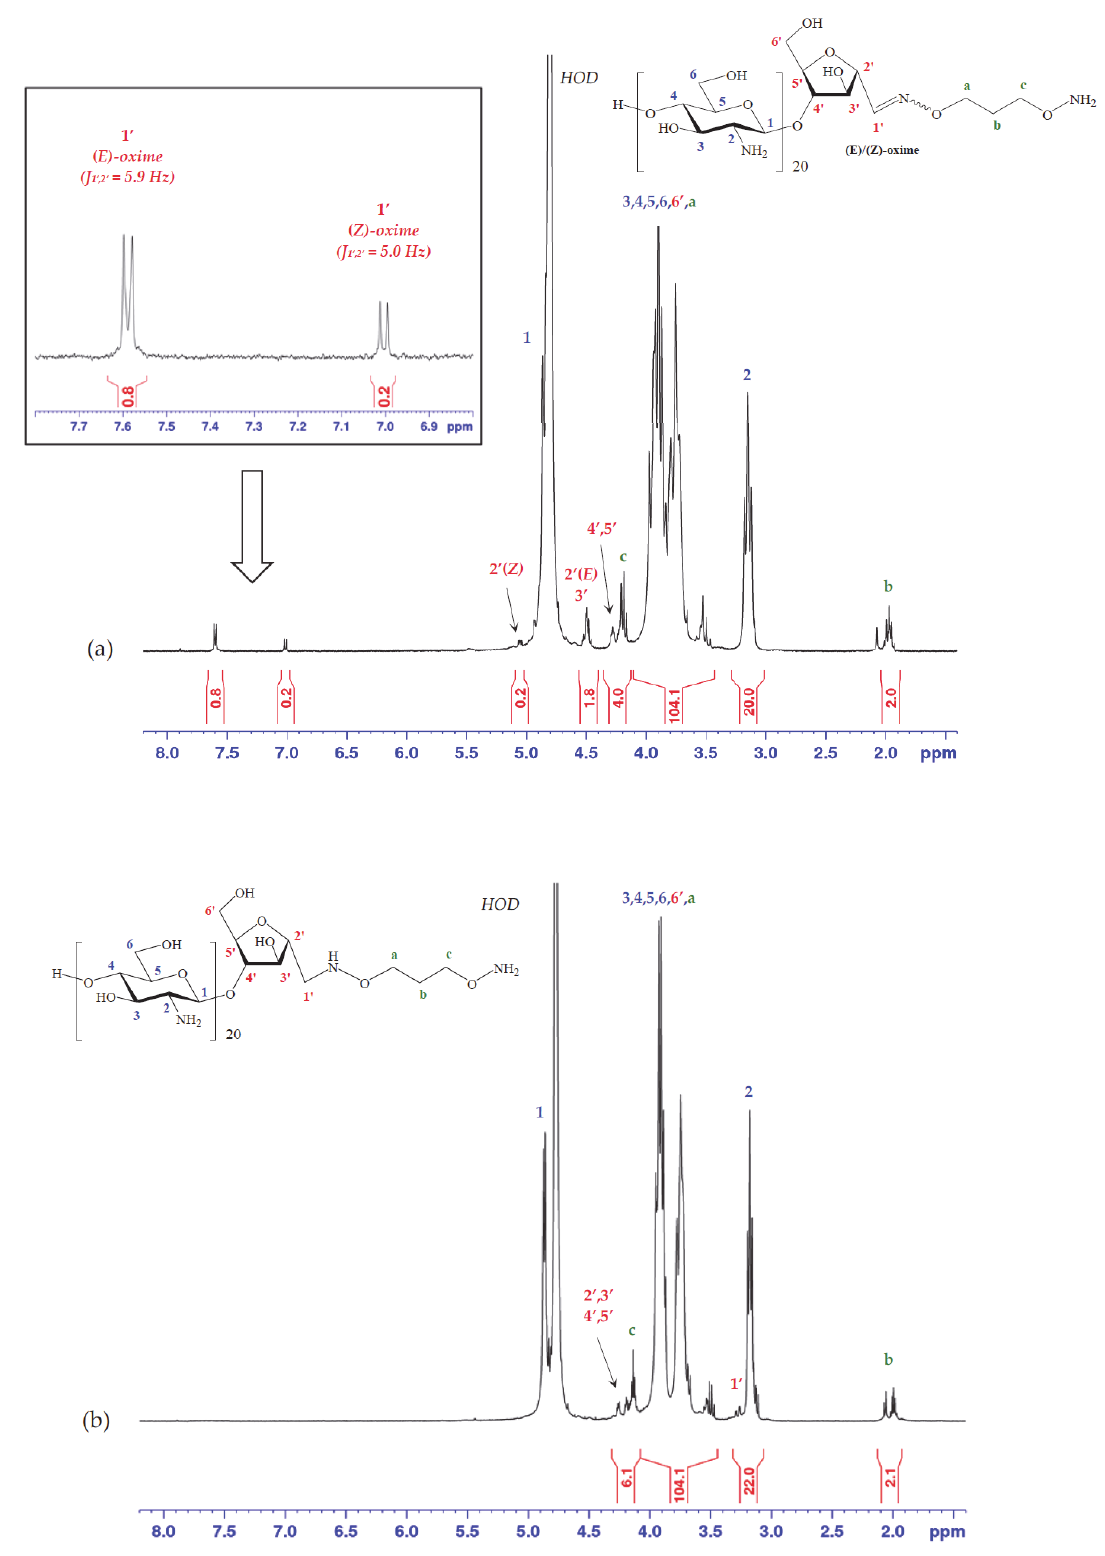
Figure 1. 1 H NMR spectra (D 2 O, 500 MHz, RT) of conjugates 1 (a) and 2 (b)